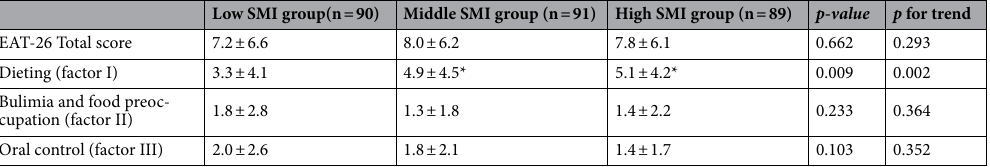
Table 5. Comparison of EAT-26 among groups. Data are mean ± standard deviation. EAT-26: Eating Attitude Test-26, SMI: skeletal muscle mass index. Jonckheere–Terpstra test was used for trend analysis. Analysis of variance was used for comparison among three groups, and Bonferroni method was used for post-hoc analysis. *Significantly different from low SMI group ( p < 0.05).